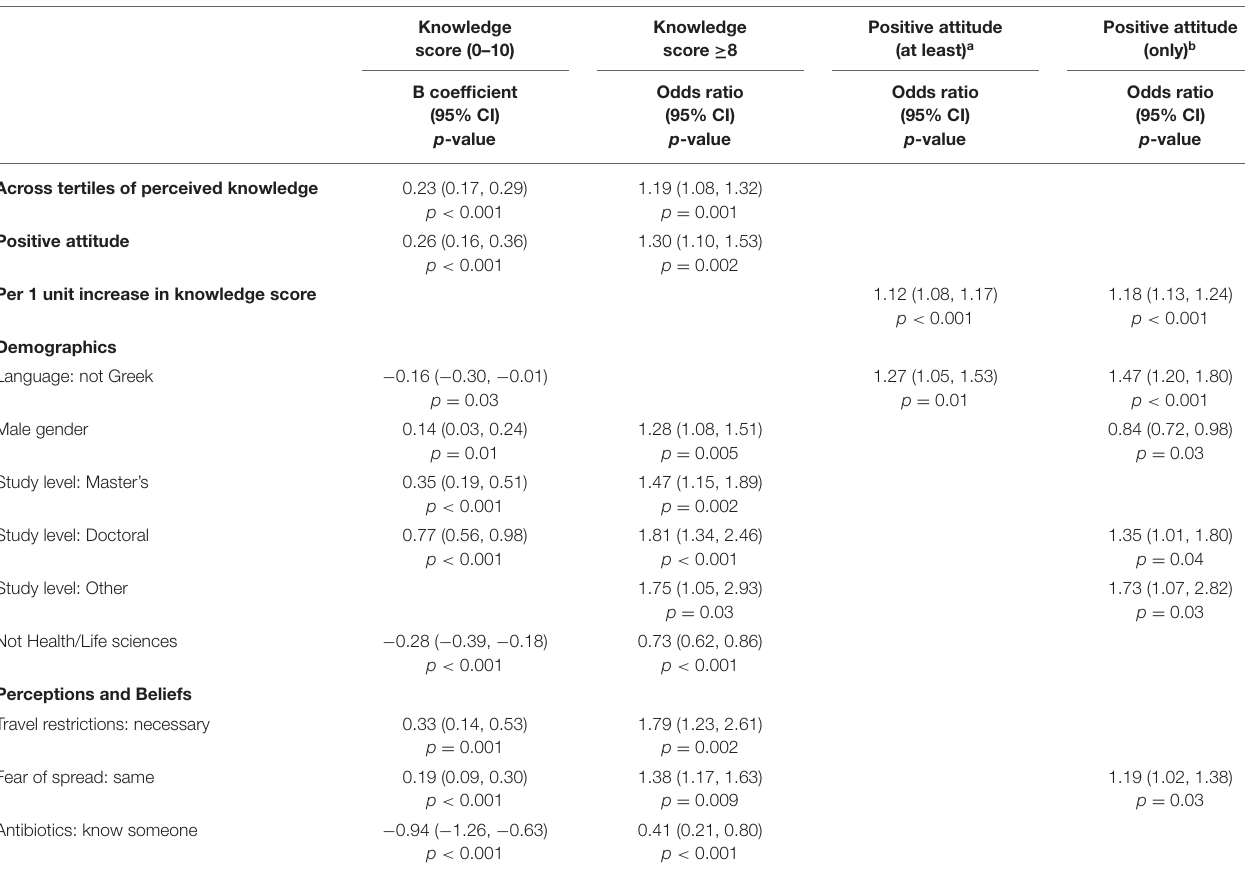
TABLE 4 | Predictors of knowledge and positive attitude toward persons with COVID-19 as estimated in stepwise linear and logistic multivariable regression models ( N =